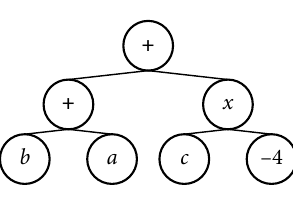
Fig. 3. An example of